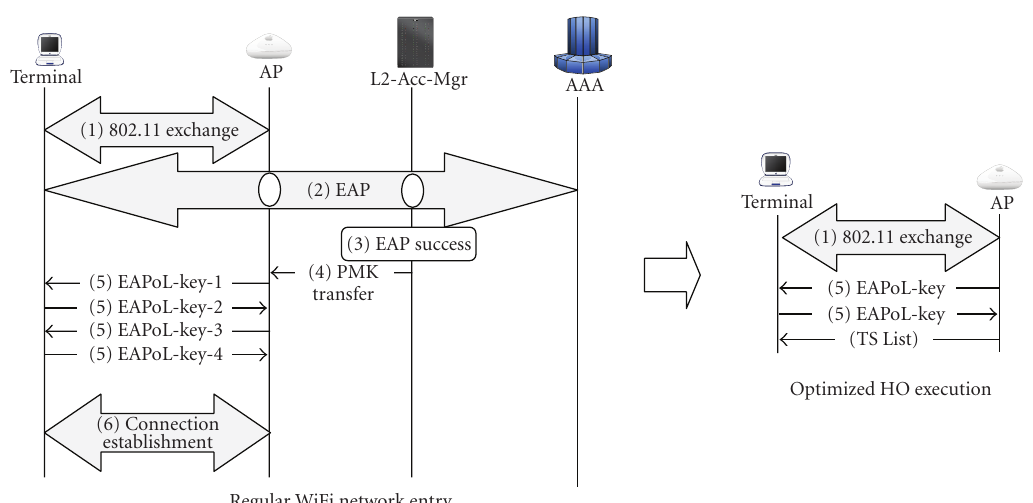
Figure 10: Association versus Re-association with a WiFi Access